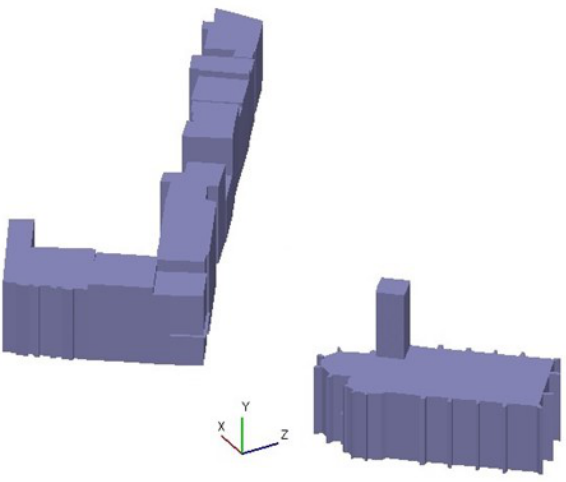
Figure 4. 3D mesh building model of the study